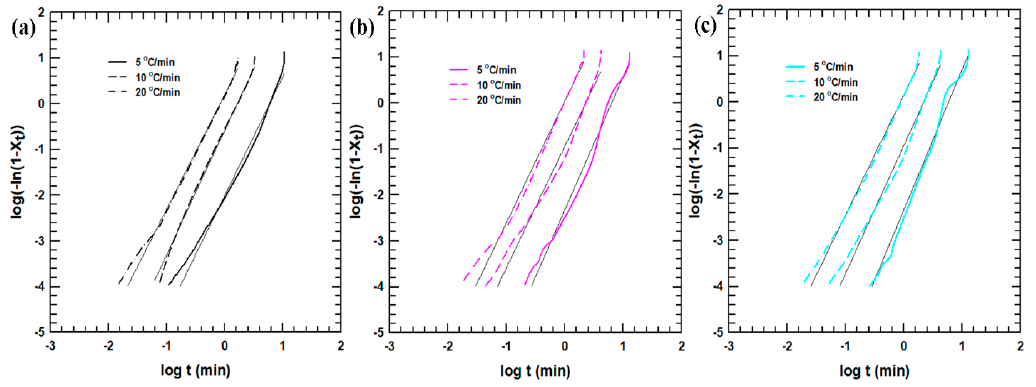
Figure 5. Avrami curves for ( a ) neat PLA; ( b ) PLA40; and ( c ) T-PLA40.